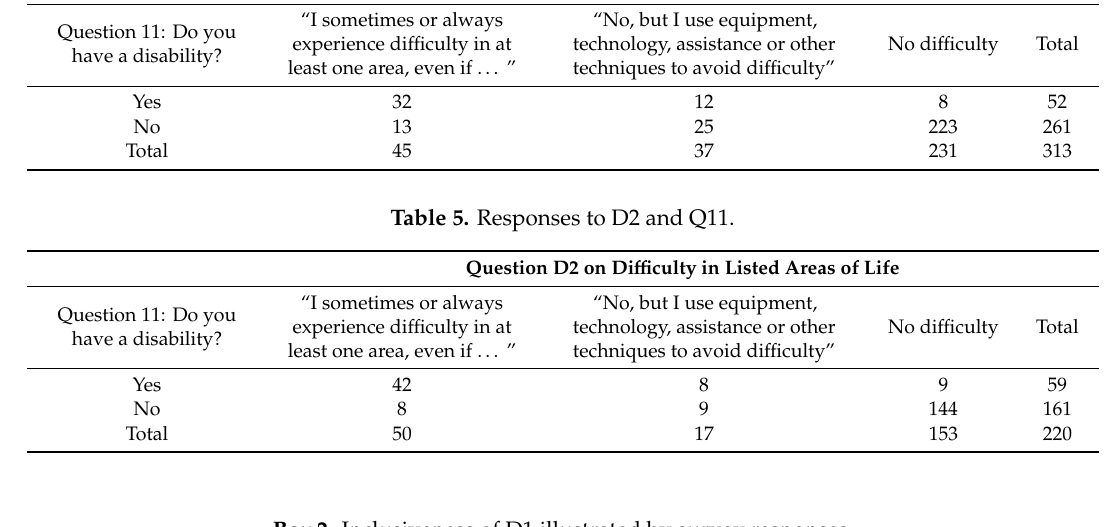
Box 2. Inclusiveness of D1 illustrated by survey